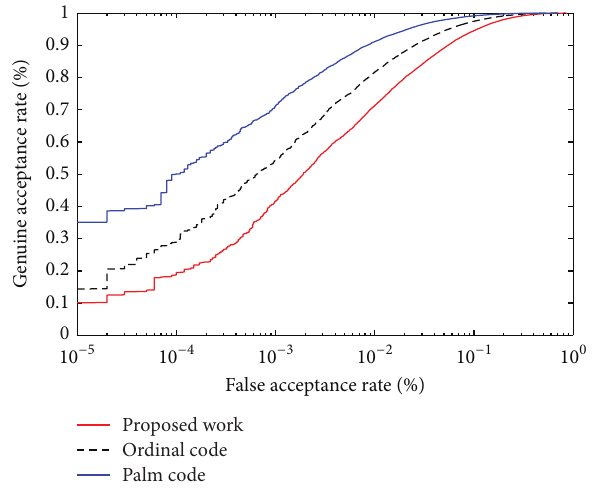
Figure 18: ROC curve using both local and global features of proposed DOST for COEP palmprint